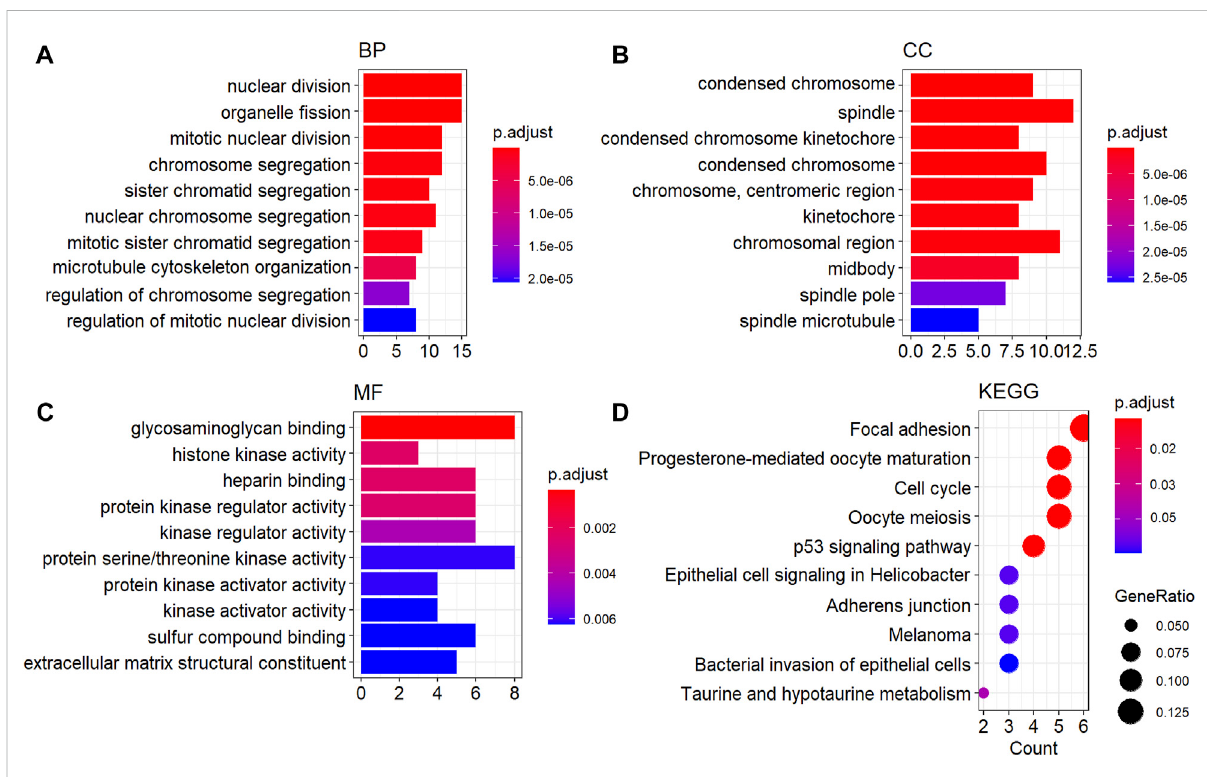
FIGURE 3 GO functional and KEGG enrichmentanalysis of oDEGs. (A) Top tenGO-BPterms, (B) top tenGO-CCterms, (C) top tenGO-MF terms, and (D) top ten KEGG pathway terms.